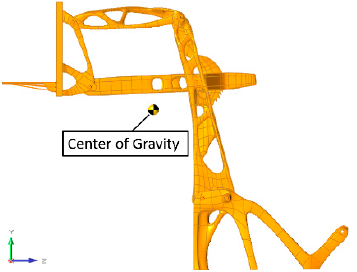
Figure 7. Topology interpreted design center of gravity for 7 ft. height configuration (worst